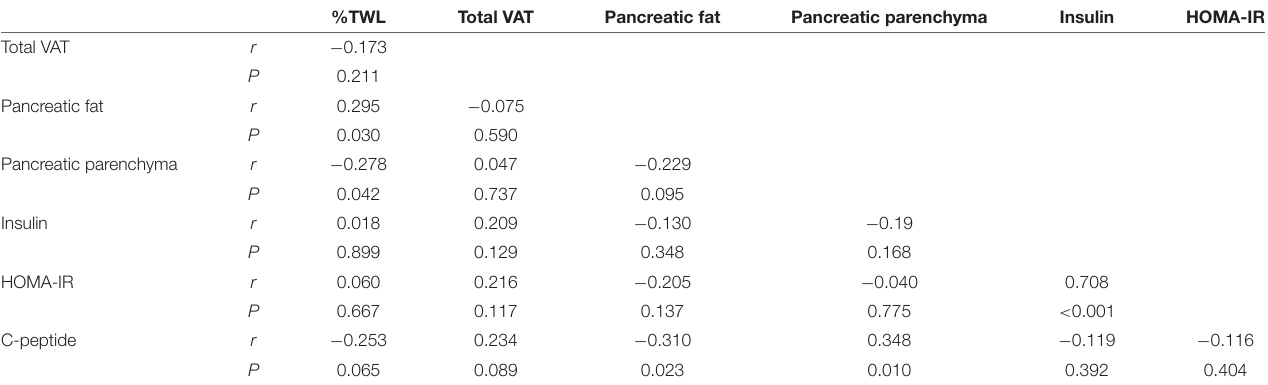
TABLE 3 | Correlation between weight loss and changes of VAT and pancreatic volume and insulin resistance. %TWL Total